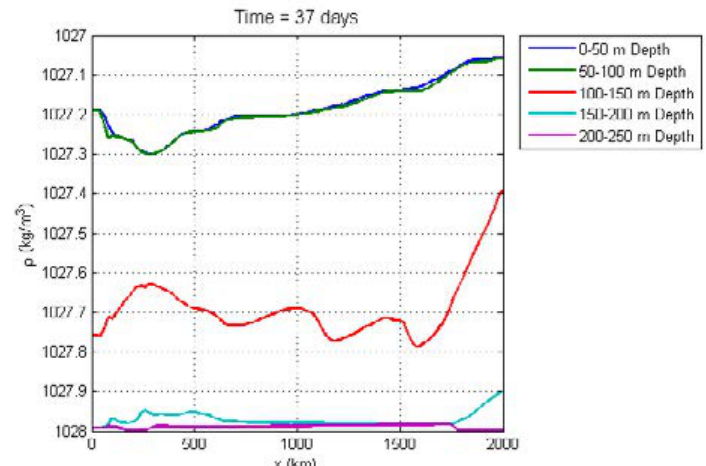
Fig. 5 : The value of density at the equator at 37 days of simulation